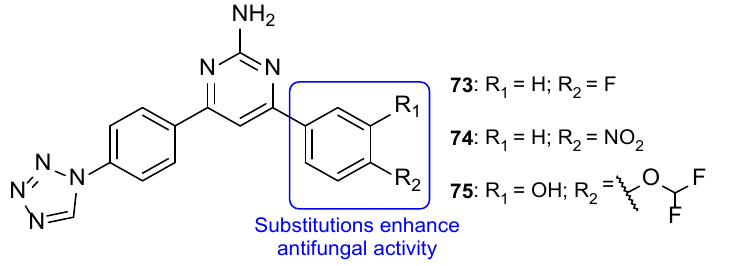
Figure 38. Chemical structures of compounds 73 – 75 , and SAR regarding the phenyl ring [118]. A series of tetrazole-chalcone hybrids was synthesized by Vembu et al. and evaluated for its antifungal activity against C. albicans , A. niger , and A. fumigatus and using fluconazole as standard. All tested compounds displayed antifungal activity against the tested strains (with MIC values ranging from <0.46 to 18 µ M). Compounds 76 and 77 (Figure 39) demon- strated good MIC values, ranging from <0.5 to 0.98 µ M, and compound 78 (Figure 39) showed the best antifungal potential of the series, with MIC values ≤ 0.46 µ M against all tested strains (when compared to fluconazole, which presented MIC values from <0.52 to 8.2 µ M, not concordant with literature results for A. fumigatus ). The addition of a nitrogen atom on the aromatic ring, leading to a pyridinyl ring (compound 79 ), resulted in a loss of antifungal activity, and introduction of a hydroxyl group (compound 78 ) led to enhanced antifungal potential (Figure 39) [119].